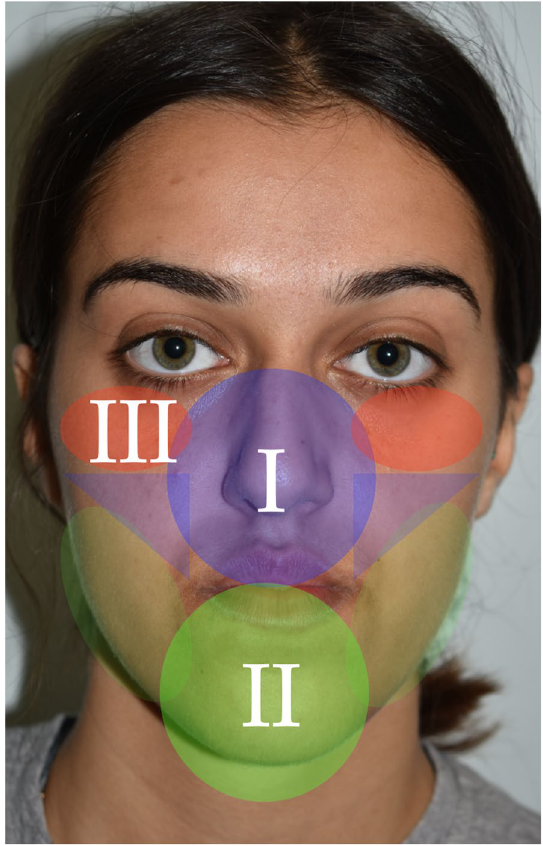
Fig. 1 Facial zones used in zonal analysis. Zone I is the nasomaxillary zone (shown in the centre in purple), and its extended zones are the cheeks (shown as the bilateral triangles in purple). Zone II is the mandibular zone (shown in the centre in green), with extended zones bilaterally. Zone III is the malar